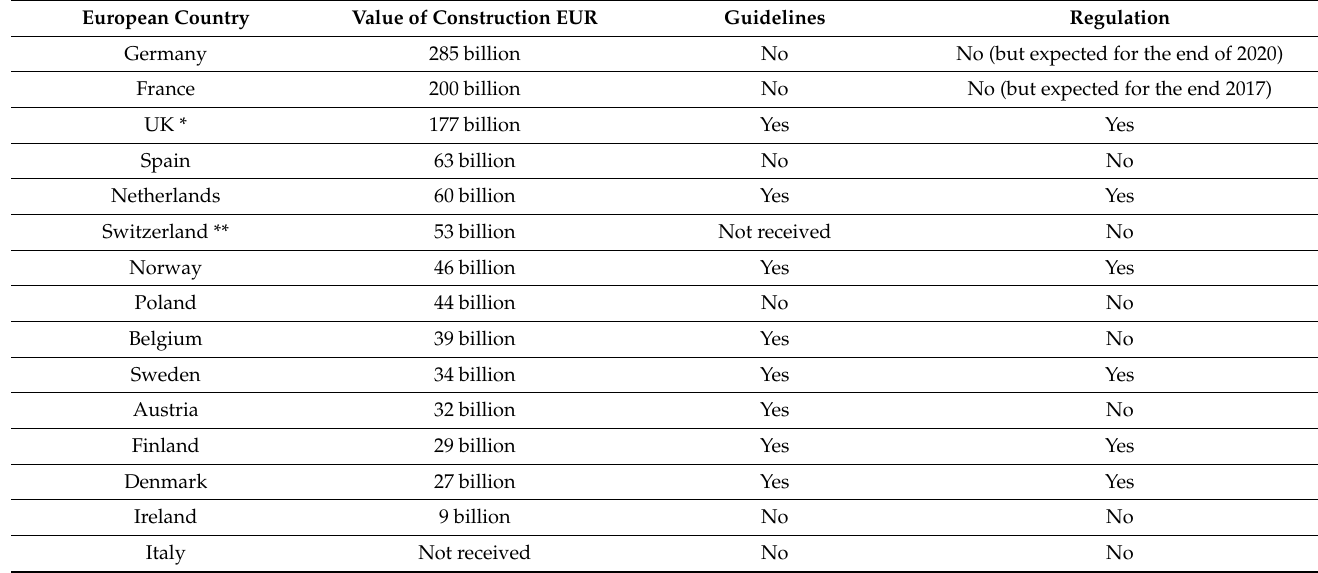
Table 1. Situation in Europe before